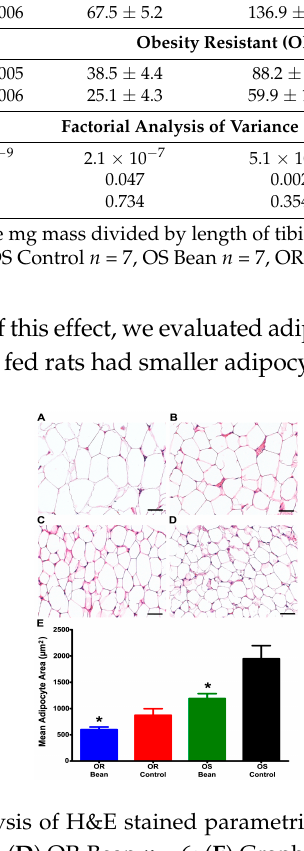
Table 3. Effect of paired-feeding of commercially processed bean powder on food efficiency ratio and visceral adiposity.